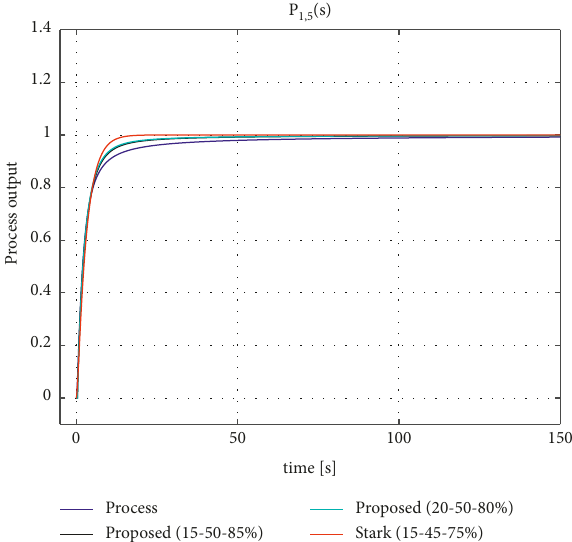
Figure 12: Process reaction curve and step responses for FFOPDT model methods # 3 and # 4 and SOPDT method # 11, respectively.